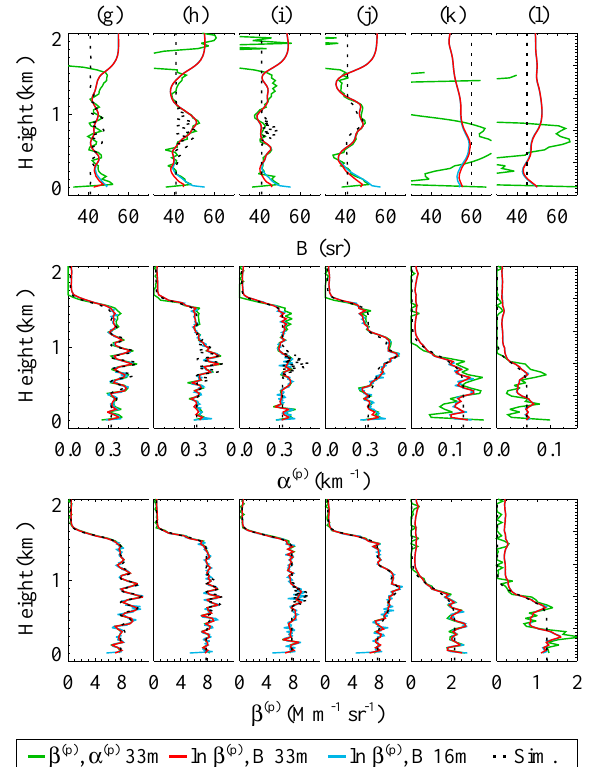
Fig. 4. Performance of the retrieval with simulated data for the lin- ear (green) and logarithmic (red) retrieval modes. (a) An idealised, well-mixed PBL with χ = 0 . 50. (b) As (a) , but observed at 20% of the previous laser energy. (c) Similar to (a) , but with χ = 0 . 89. (d) As (a) , but with a larger B and the addition of an aerosol layer at 800m. (e) As (a) , but applying an incorrect nonlinear correction. (f) Observation of a cloud, shown on a log scale.